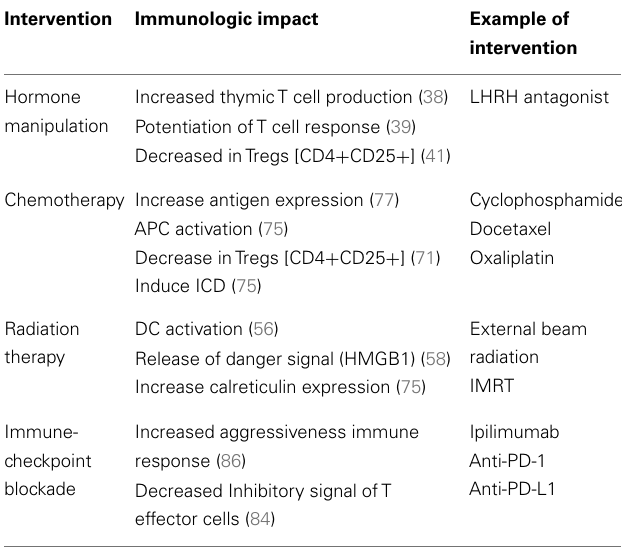
Table 1 | Effects on immune system of different interventions in cancer